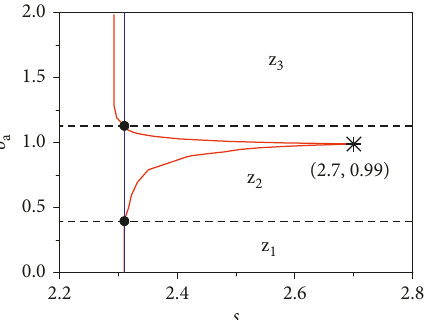
Figure 15: The effect of the natural frequency of the DVA on the instability threshold of the rotor/seal system as ζ a